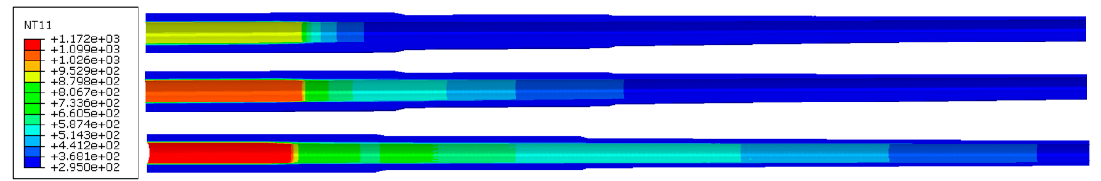
Figure 15. Propellant gas energy. In the early stage of interior ballistics, since the combustion rate of the propellant is increasing, the values of E 1 , E 2 , E 3 , E 4 and E 5 are relatively low. So, E 6 increases with time. In the later stage of interior ballistics, conversely, because the combustion rate of the propellant continuously decreases until zero, the values of E 1 , E 2 , E 3 , E 4 and E 5 are relatively high. So, E 6 decreases with time. 3.6. Energy Distribution Proportion According to application characteristics, E 1 and E 2 belong to the effective energy, which designers aim to get, E 3 , E 4 and E 5 belong to the secondary energy, which appears inevitably, and E 6 belongs to the potential energy, which is able to convert to other kinds of energies. Based on the calculation results above, Table 4 summarizes energy values at 18.9 ms. Additionally, Figure 16 illustrates the proportionate relationship between each kind of energy and total propellant chemical energy. For instance, the percentage of effective energy, η 1 , can be given as: 1